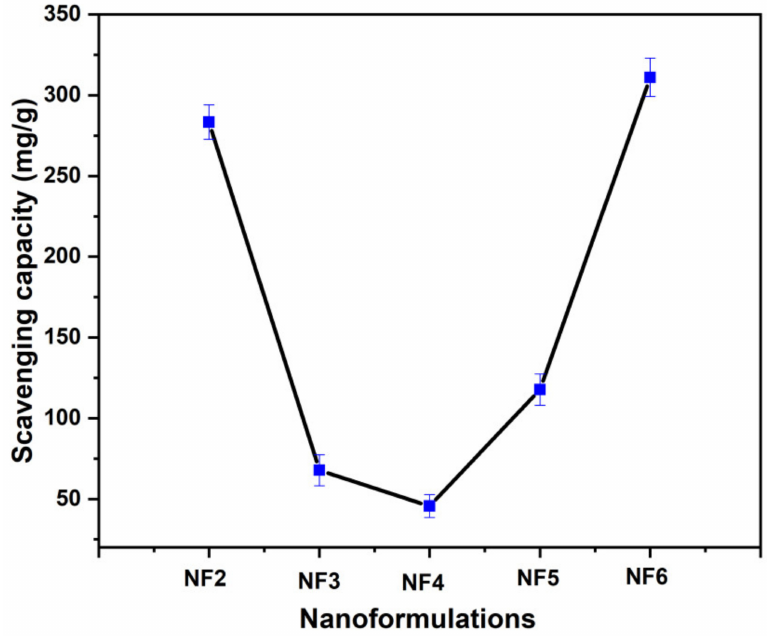
Figure 6. The behavior of scavenging procedure using the phosphomolybdate method for di ff erent